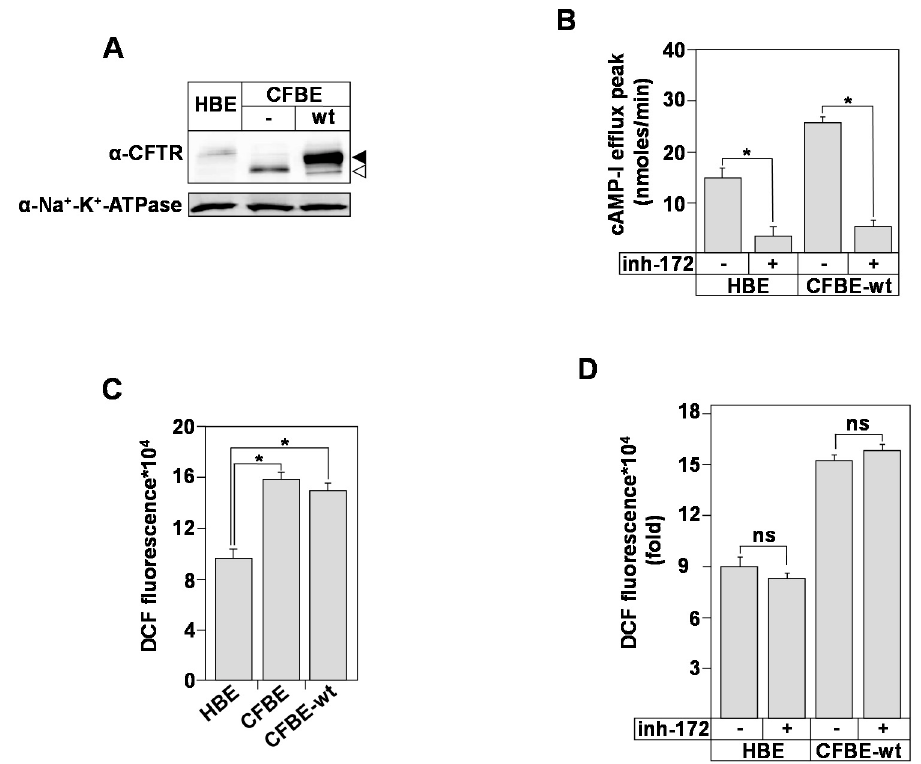
Figure 1. Characterization of CF Transmembrane Conductance Regulator (CFTR) expression and reactive oxygen species (ROS) production. ( A ) Expression of CFTR protein normalized to Na + /K + -ATPase in human bronchial epithelial cells; control (healthy bronchial epithelial) (HBE), cystic fibrosis (CFBE), and CFBE stably transfected with wild (wt) type CFTR (CFBE-wt). Black arrow corresponds to fully glycosylated mature CFTR form (band C). White arrow corresponds to core- glycosylated CFTR (band B). ( B ) Iodide efflux used as a functional assay to determine the activity of CFTR chloride channel in HBE, CFBE, and CFBE-wt cells, in the absence or presence of 10 µ M of inh-172. ( C ) Measurement of ROS concentration in HBE, CFBE, and CFBE-wt cells using dichlorodihydrofluorescein (DCF) fluorescent probe. Cells were incubated with 50 µ M dichlorodihydrofluorescein diacetate acetyl ester (H2DCFDA) for 45 min. The conversion of H2DCFDA to fluorescent DCF was measured at λ ex/ λ em of 495/527 nm. ( D ) Measurement of ROS concentration in HBE and CFBE-wt, in the absence or presence of inh-172 using the DCF fluorescent probe. Values with an asterisk are significantly different from their corresponding controls ( p < 0.05). ns: nonspecific. Data are expressed as mean ± SEM ( n = 6).